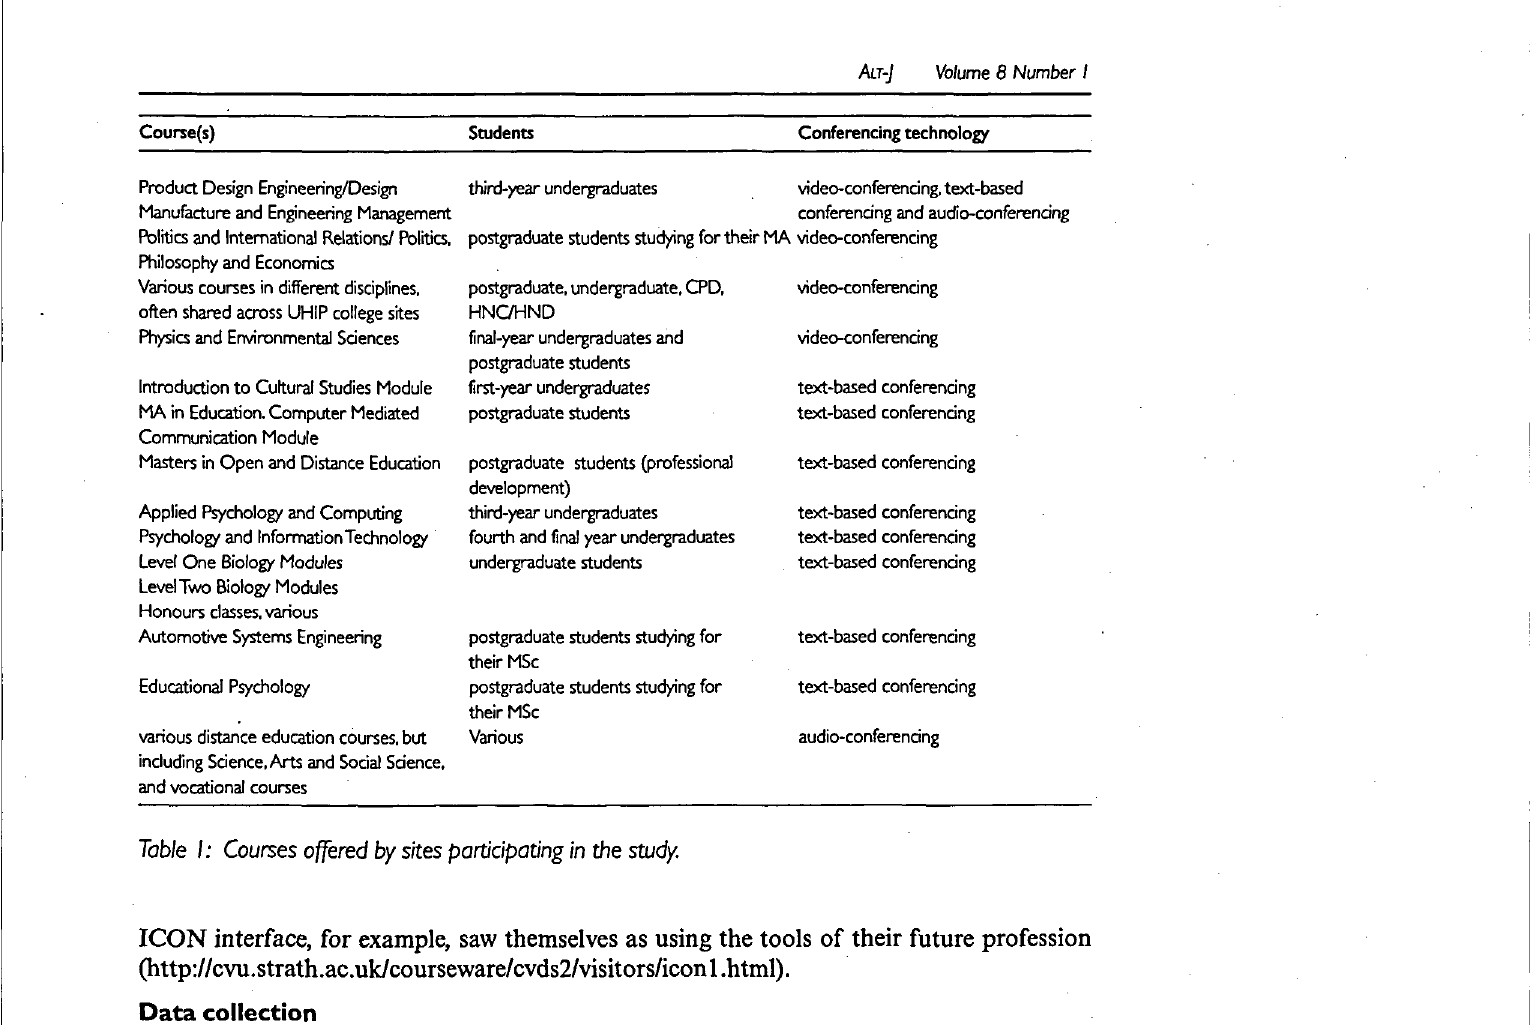
ICON interface, for example, saw themselves as using the tools of their future